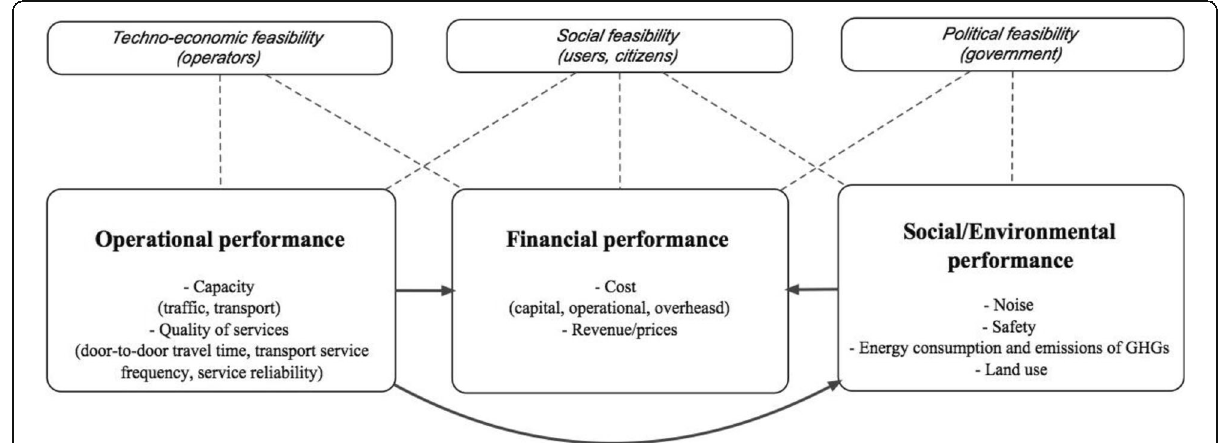
Fig. 5 The considered HL, HSR, and APT performances explored in this